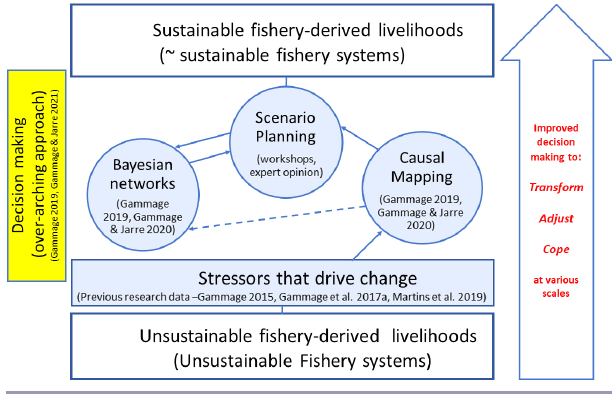
Fig. 1 . Graphical overview of the overarching framing and the methods (with references to data sources) as used in this research. To achieve more sustainable livelihoods and more sustainable fishery systems, fishers need to move beyond merely coping with change toward adjusting and transforming their fishery systems at various temporal and spatial scales. Using structured decision-making tools, stakeholders’ knowledge of stressors that make them vulnerable to change are used in a layered, iterative, and inductive approach to address the various aims of the research.